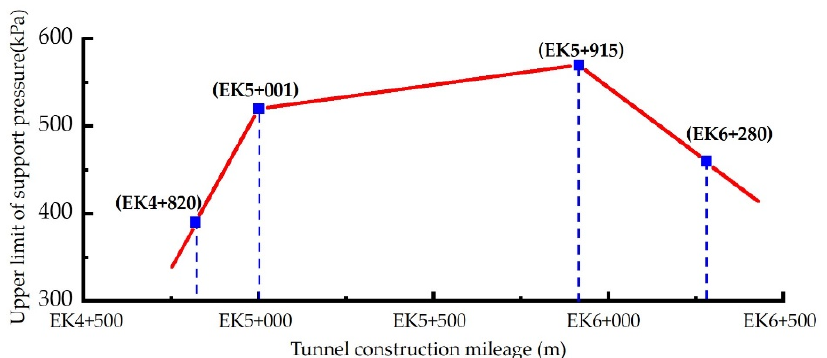
Figure 19. Predicted value of upper limit of shield slurry support pressure in tunnel crossing reser- voir section.